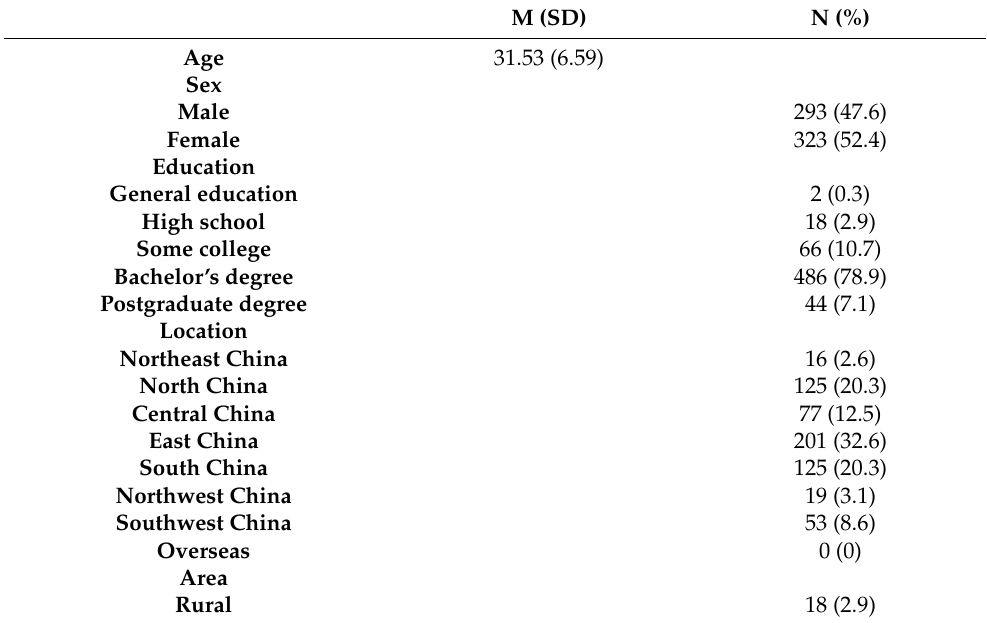
Table 1. Demographic